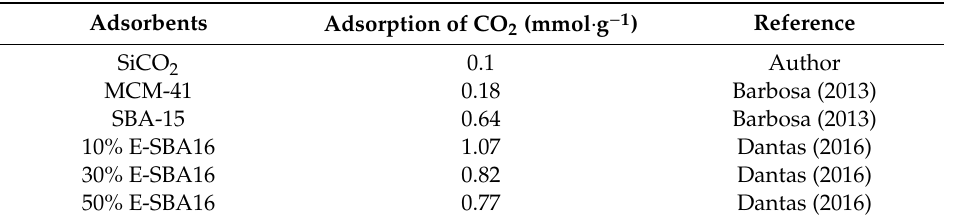
Table 3. CO 2 adsorption capacities at low pressures.